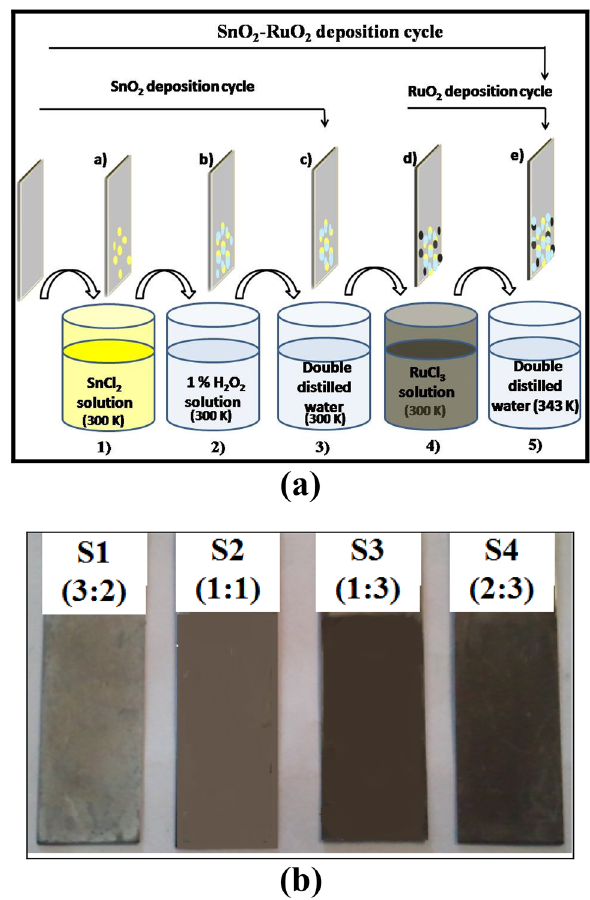
Fig. 1 a Schematic experimental setup of SILAR method for deposi- tion of SnO 2 –RuO 2 mixed film, b Photograph of SnO 2 –RuO 2 mixed films deposited by SILAR on stainless steel substrate (> 8 cm 2